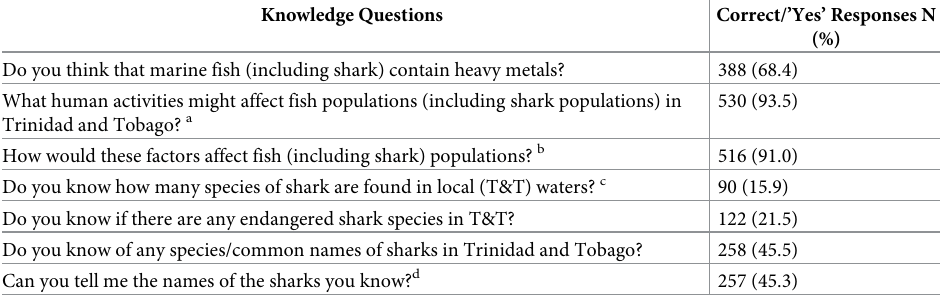
Table 2. Frequency distribution of participant’s knowledge responses regarding sharks and environmental factors affecting sharks in Trinidad and Tobago (Total N = 567).